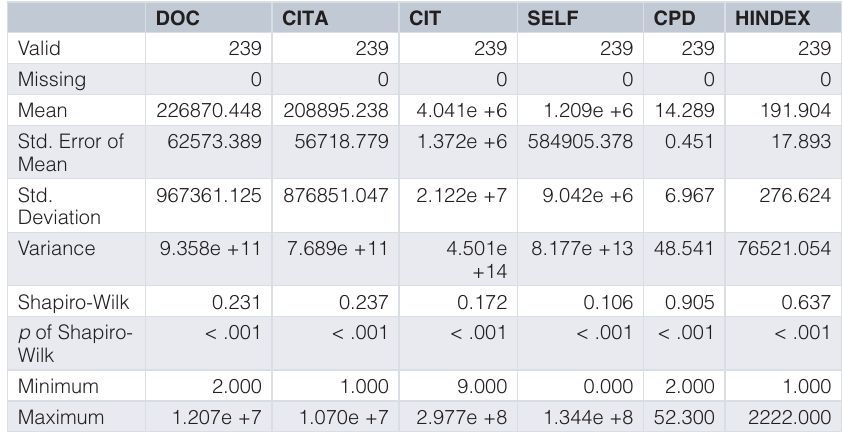
Table 1. Descriptive statistics of SCIMAGOJR indicators (1996–18 August